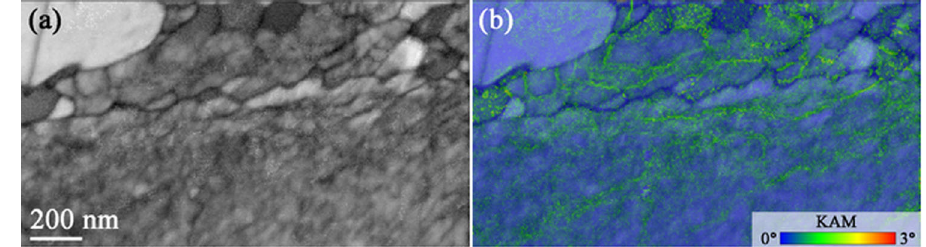
Fig. 7 TKD results of the surface work-hardened layer of A2 sample before SSRT tests. a Grain structure, b KAM